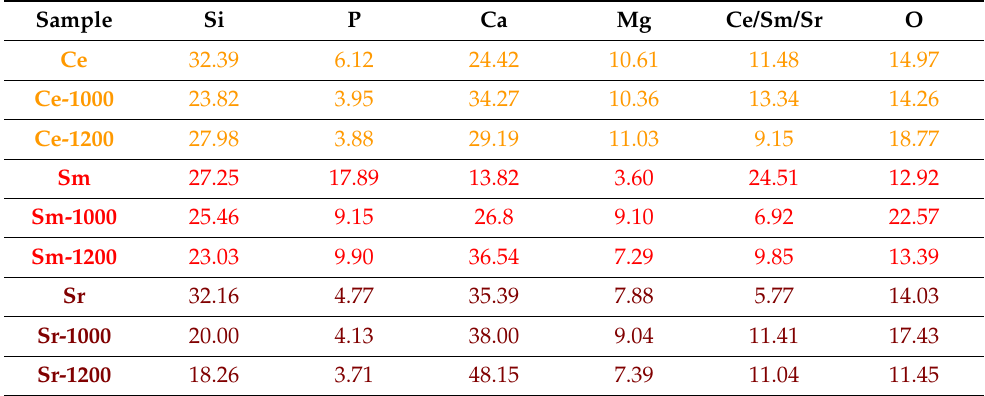
Table 2. Elemental composition of the developed